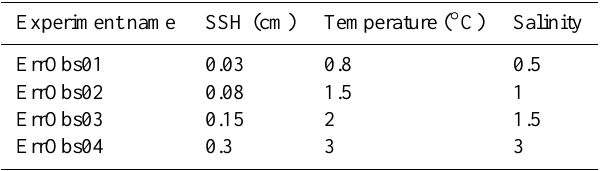
Table 1. Observation errors of SSH, temperature and salinity for sensitivity experiments ErrObs01 to